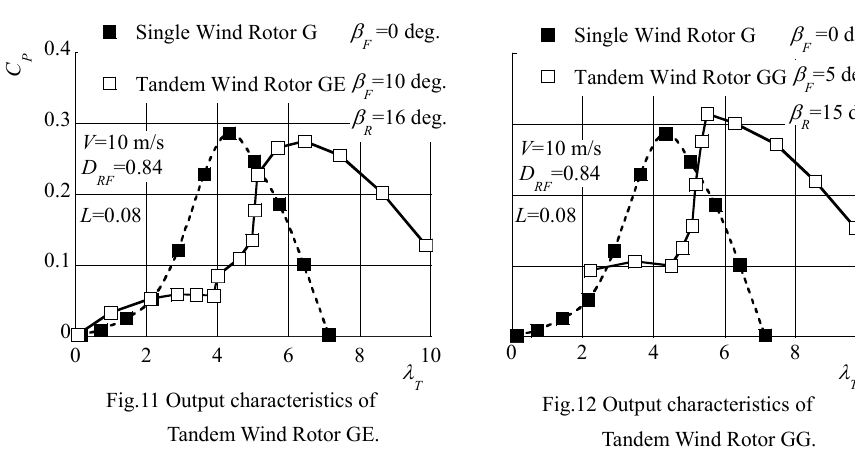
Fig.10 Effects of blade setting angles on the output characteristics.